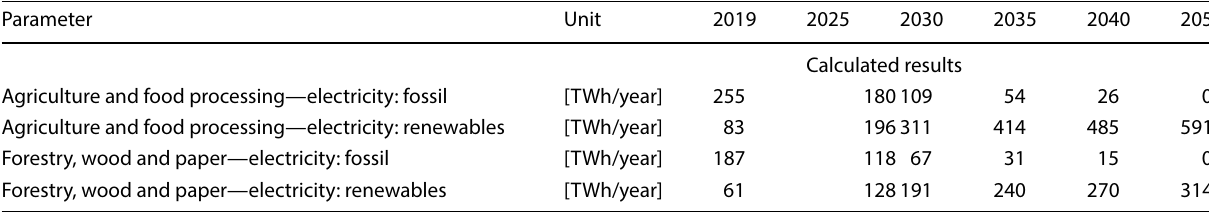
Table 13 Results: Electricity supply for the sectors analysed until 2050 Parameter